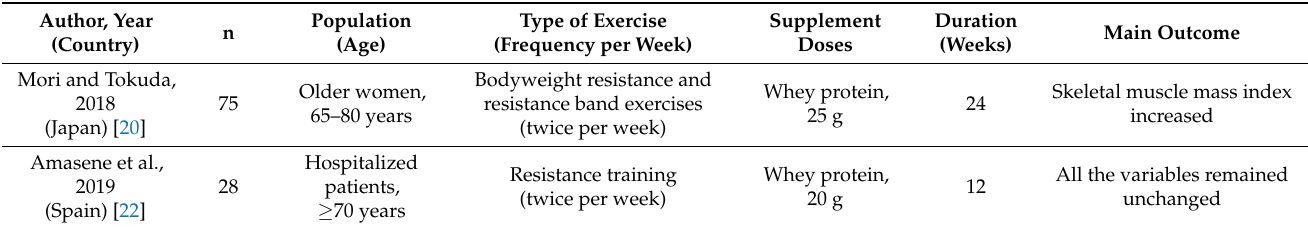
Table 2. Randomized clinical trials that included exercise and supplementation as the strategy to improve sarcopenia in elderly